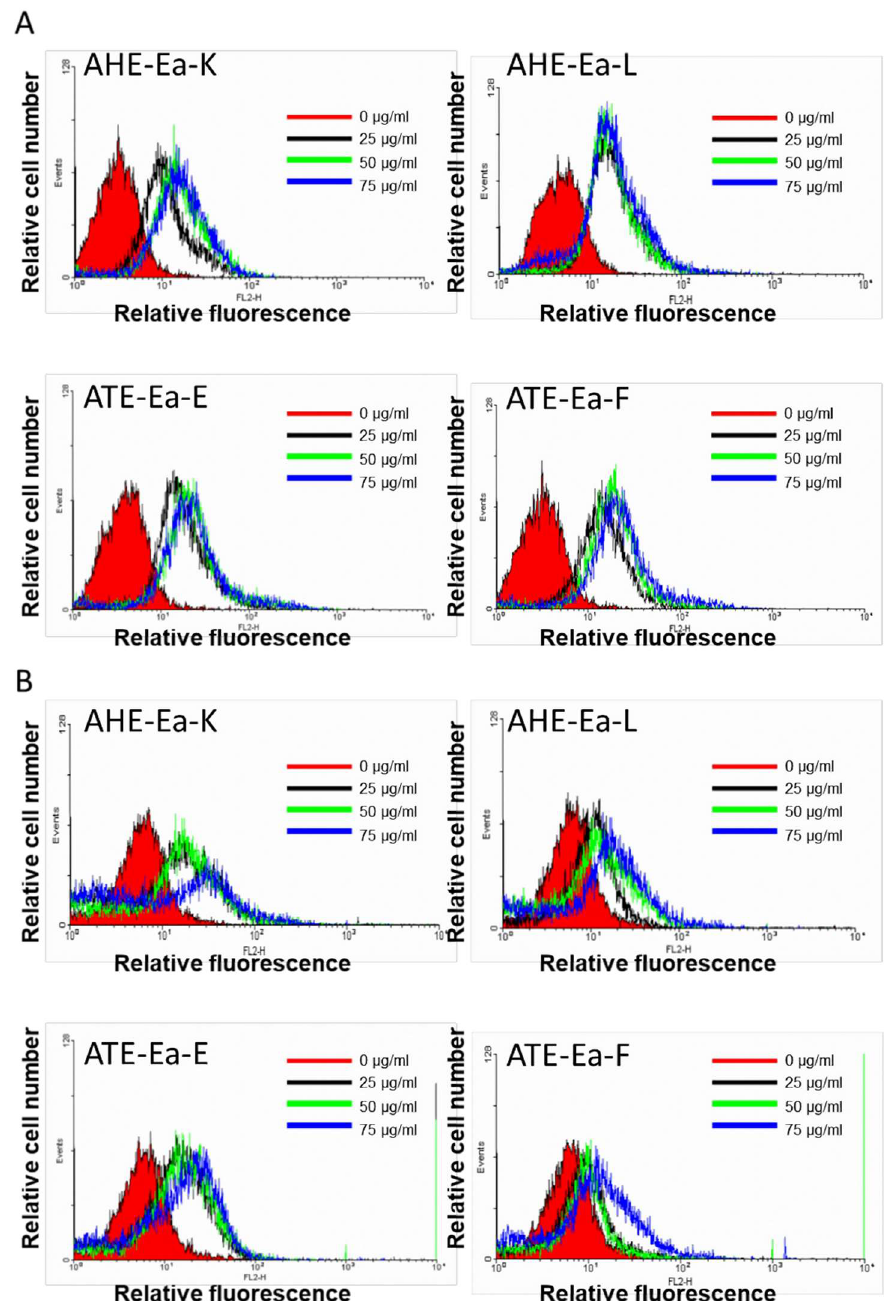
Figure 3. The effects of adlay extract subfractions on the activity of caspase-3 in ( A ) MCF-7 or ( B ) HeLa cells. The MCF-7 and HeLa cells were cultured in MEM and DMEM media containing 0, 25, 50 and 75 µ g/mL of AHE-Ea-K, AHE-Ea-L, ATE-Ea-E or ATE-Ea-F for 48 h. Then, the cells were stained using a caspase-3 kit and analyzed by flow cytometry. Each data point represents as the mean ± SD ( n =